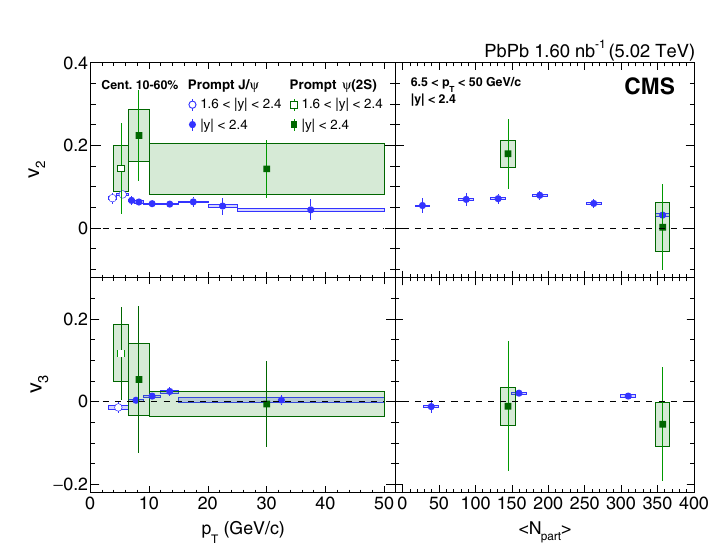
N part (right) for prompt ⟨ ⟩ y < 2.4 and y < 2.4, respectively (left panel). The results for p T | | | | y < 2.4. The vertical bars denote the statistical | |